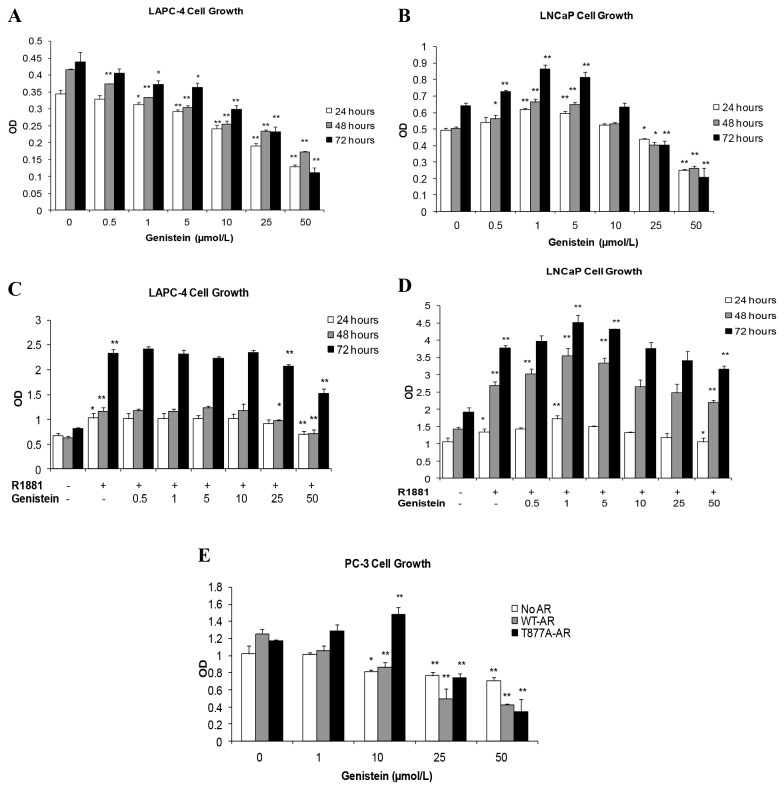
Effects of genistein on PCa cell growth and viability measured by MTS assay.The data represent the mean ± SD (standard deviation) of three experiments each in triplicate. A and B: Graphic presentation of the effects of different concentrations of genistein on LAPC-4 (A) and LNCaP (B) cell growth. C and D: The effect of combined treatment with genistein and R1881 on LAPC-4 (C) and LNCaP (D) cell proliferation. E: The effect of genistein treatment for 24 hours on the growth of non transfected PC-3 cells or PC-3 cells transfected with either WT-AR or the T877A mutant AR. OD; optical density. *p < 0.05, **p <0.01 for comparisons with the control groups.